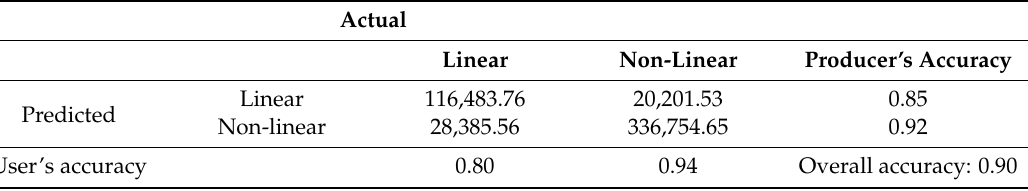
Figure 5. Results of vegetation classification. Green areas have been correctly classified as linear vegetation (light green) and non-linear vegetation (dark green). Red areas have been wrongly classified as linear vegetation (light red), while dark red areas have been wrongly classified as non-linear vegetation. Cross plots 1–6 illustrate the variation in linear vegetation elements (in yellow) and terrain points (in purple), as visible from the LiDAR point cloud. Table 3. Confusion matrix of the automatically segmented against the manually annotated set of linear and non-linear vegetation objects (m 2 ).